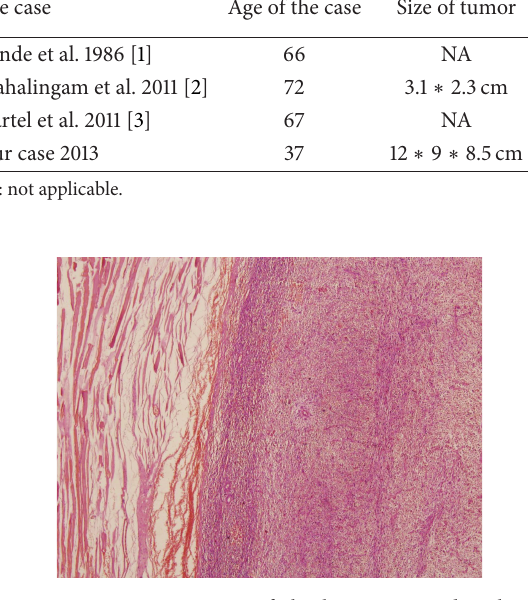
Figure 3: Microscopic image of the biopsy, stained with H&E; spindle cells composing storiform pattern (H&E × 100).